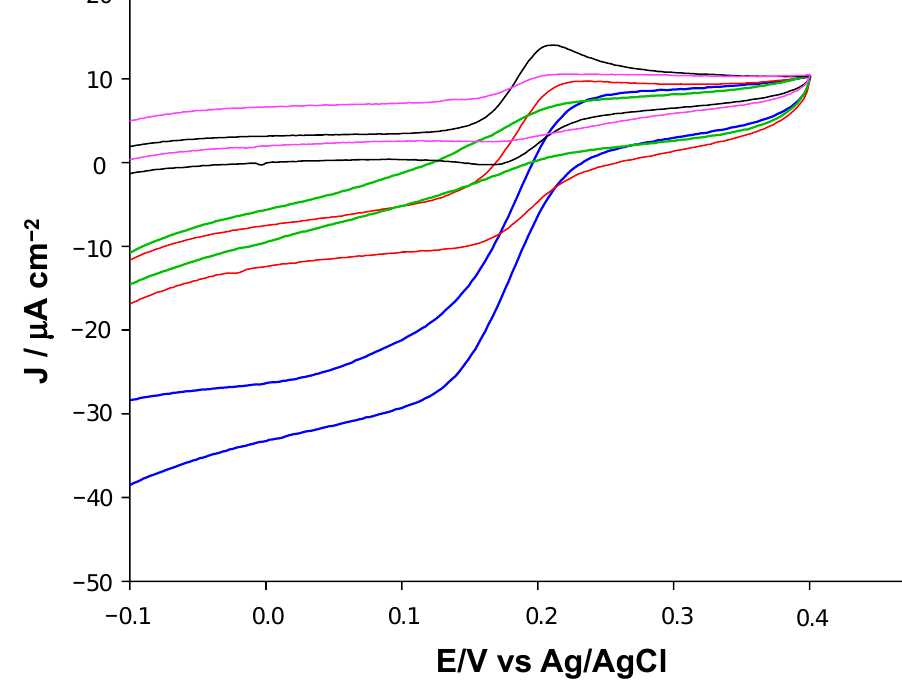
Figure 2. CVs of 50 µ M dopamine in PBS (0.1 M, pH 7.2, KCl 0.1 M) on a GPH/SPE (pink line), a ChitNPs/GPH/SPE (black line), a Tyr/Chit/GPH/SPE (green line), a Np-Tyr/ChitNPs/GPH/SPE (red line), and a LbL-Tyr/ChitNPs/GPH/SPE (blue line). Scan rate: 10 mV s −1 . An increase in the reduction peaks was observed for both